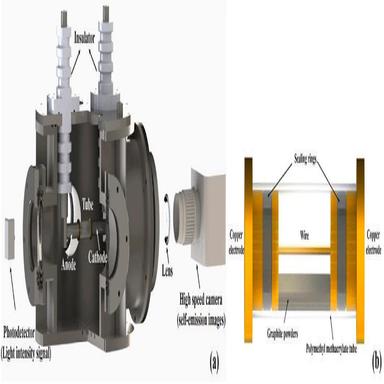
Schematic of the experimental setup (a) and the confined tube (b).